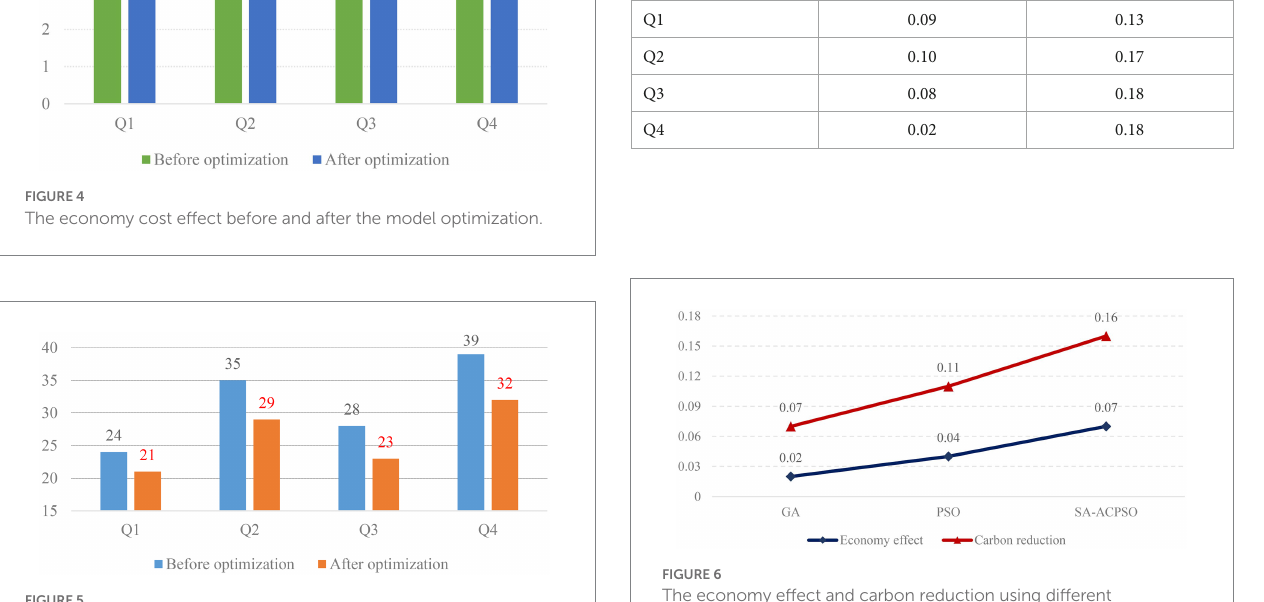
FIGURE 5 The carbon emissions before and after